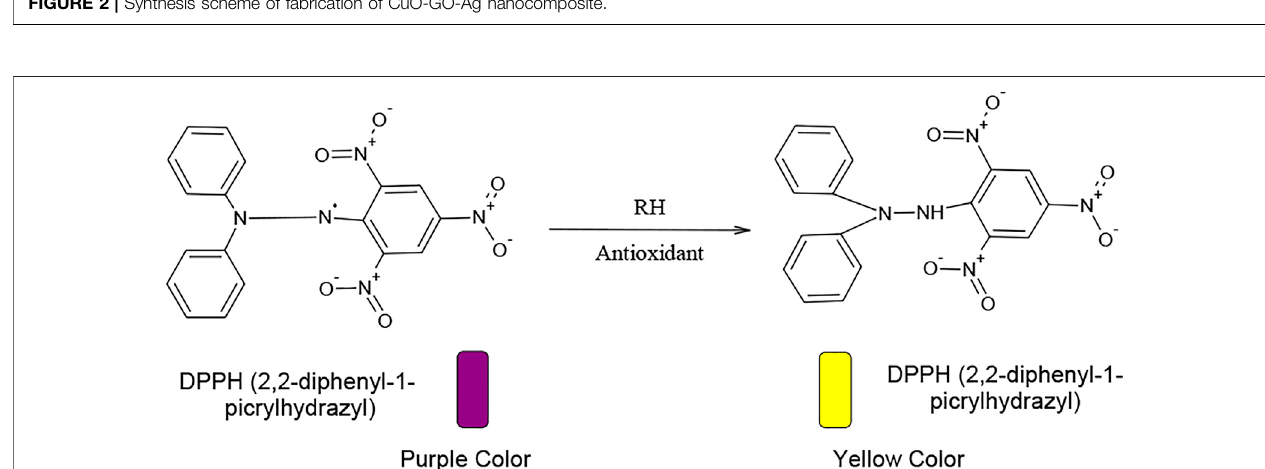
FIGURE 2 | Synthesis scheme of fabrication of CuO-GO-Ag nanocomposite.